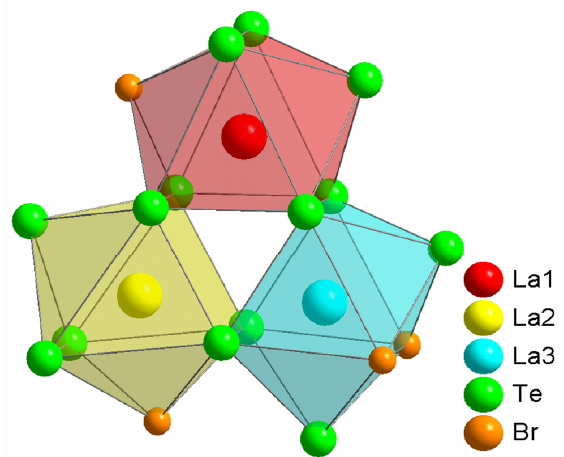
Figure 1. The building block La crystallograhically independent La atoms (La1: red; La2: yellow; La3: blue) and their surrounding by Te and Br atoms. Interatomic distances in pm and angles in degrees